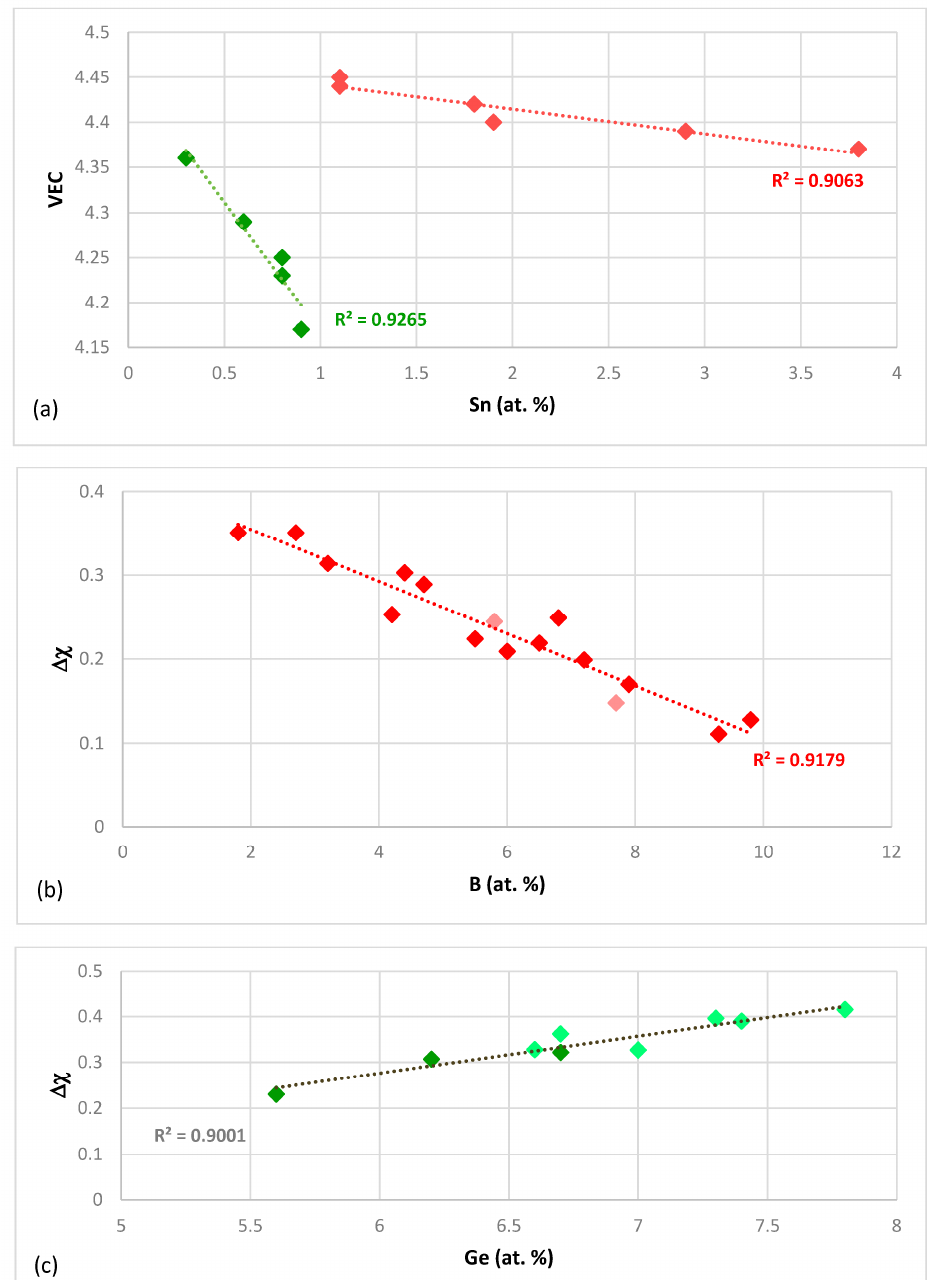
Figure 2. Relationships between the silicide parameters VEC and Δχ and solute additions that substitute Si in Nb 5 Si 3 . ( a ) Shows the relationship between VEC and Sn (at.%) in Nb 5 Si 3 . The red diamonds are for alloys that contain Ge and the green diamonds for alloys that contain B—( b , c ) show the relationships between Δχ and B (at.%) ( b ) or Ge (at.%) ( c ) in Nb 5 Si 3 . In ( b ) the light red diamonds are for alloys with B and Sn and in ( c ) the dark green diamonds are for alloys with Ge and Sn. The silicide parameter Δχ also can separate the alloying behaviour of Hf in the normal Nb 5 Si 3 and Ti rich Nb 5 Si 3 but the data falls in two distinct parts with no strong relationship (the R 2 value is low). When the data for Sn is considered, the silicide parameter Δχ can separate the data into two